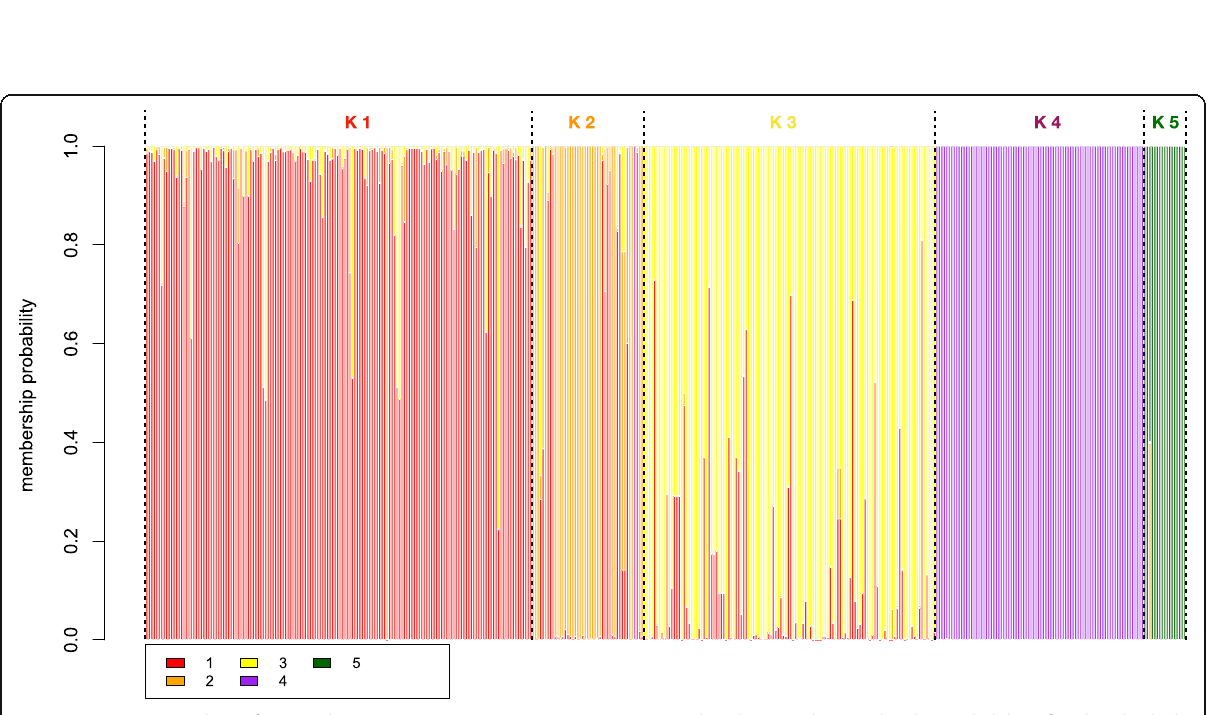
Fig. 3 Discriminant analysis of principal component (DAPC) genotype composition plot. Showing the membership probability of each individual ’ s (columns) assignment of genotype to each clusters K1 – K5. Mis-assigned individuals can easily be identified as well as F1 hybrids with mixed